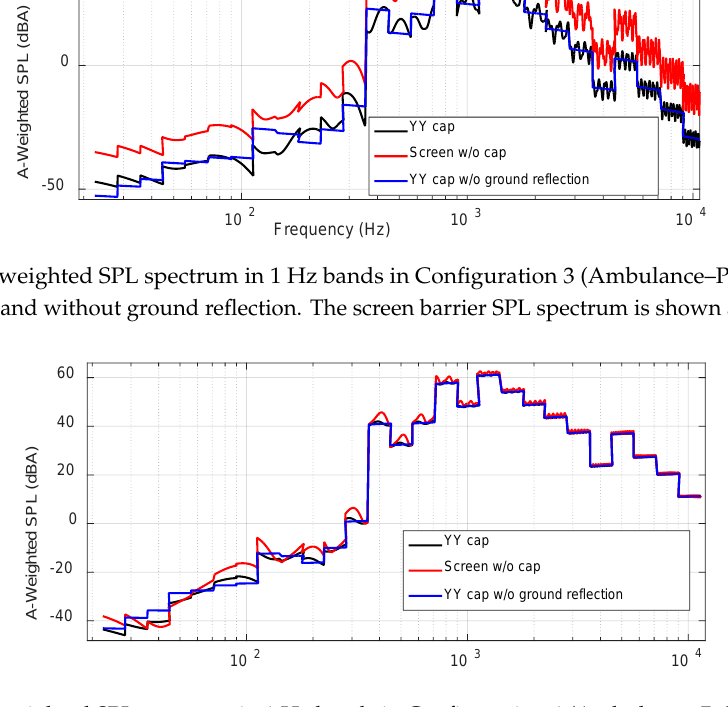
Table 1. Global sound pressure level (SPL) (dBA) at receiver